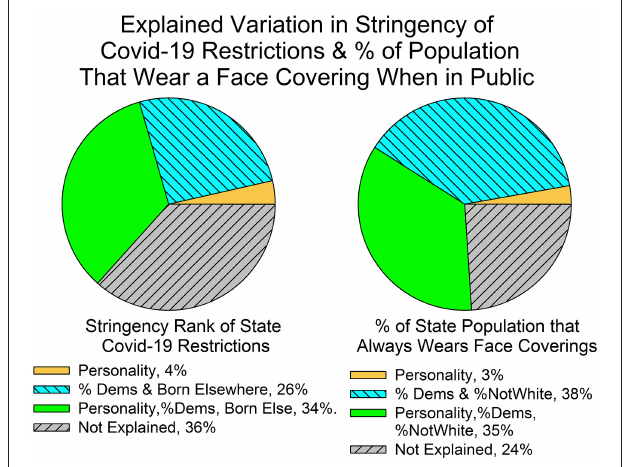
FIGURE 1 | The sectors represent the common variance of the two personality factors, the two non-personality factors, and the shared variance among the two personality and the two non-personality measures. The size of the sector is proportional to the amount of variance its predictors explain. See text for other